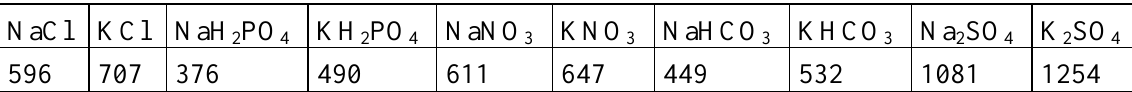
Table 1. Conductivity ( µ S) of the different solutions